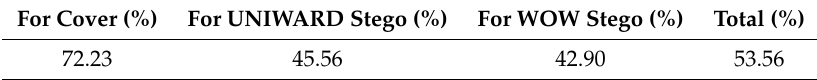
Figure 10. Ternary classification through transfer learning. Table 3. Ternary classification rates obtained by transfer learning ( bpp = 0.4).